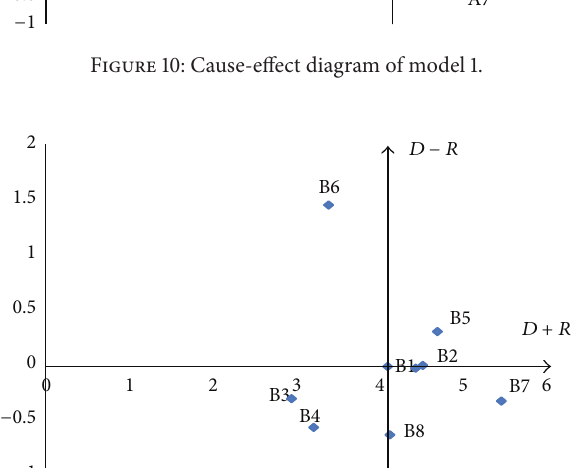
Figure 13: Driving power-dependence diagram of model 1. Figure 11: Cause-effect diagram of model 2. elements (e.g., the driving power and dependence in ISM and the prominence and relation in DEMATEL) as well as present the relationships in easily understood